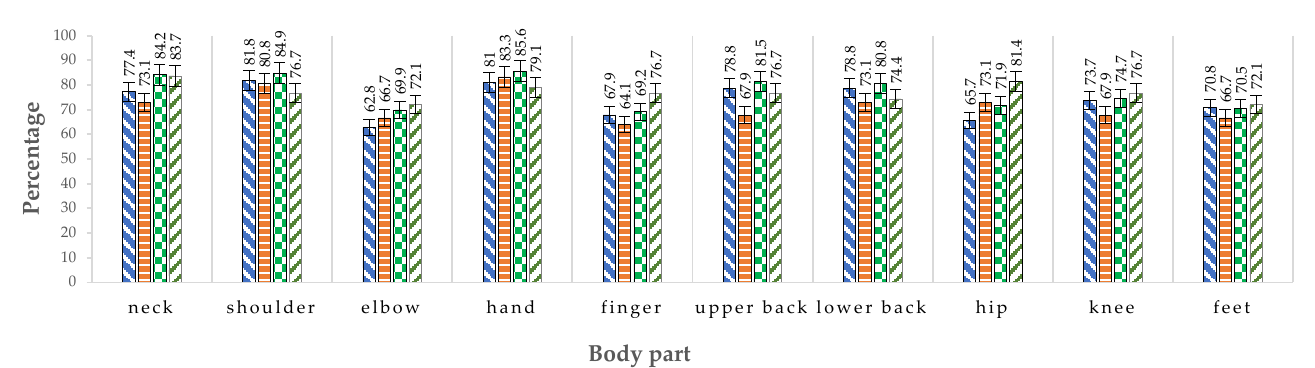
Figure 1. Prevalence of MSDs in body parts for different ethnic worker groups. The relationships between ergonomic risk factors classified by domain among ethnic workers are presented in Table 4. There were positive correlations between awkward pos- ture, heavy carrying and lifting, repetitive activity, land slope, and equipment ( p < 0.01), with S pearman’s rank coefficients (r s ) ranging from 0.304 to 0.528. Table 4. Spearman’s rank coefficients (r s ) between ergonomic risk scores classified by domain among ethnic workers.